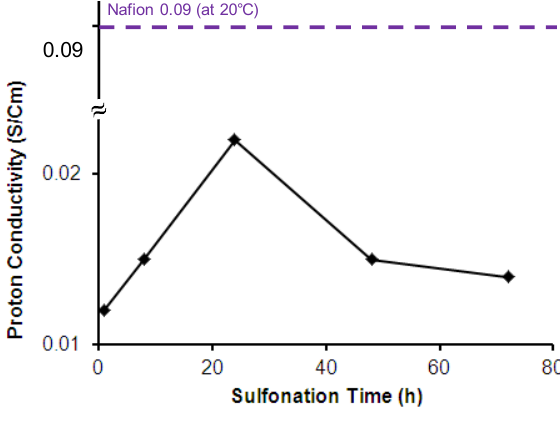
Figure 5. Proton conductivity of s - OPBI as a function of the sulfonation